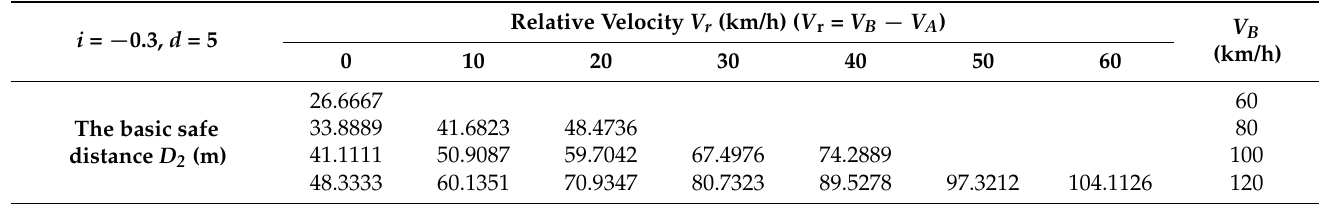
Table 9. The basic safe distance D 2 based on V B between 60 and 120 km/h when i = − 0.3 and d = 5. i = − 0.3, d = 5